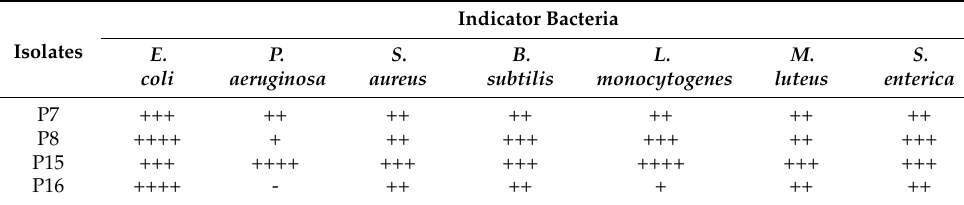
Table 4. Antimicrobial spectrum of selected LAB strains.